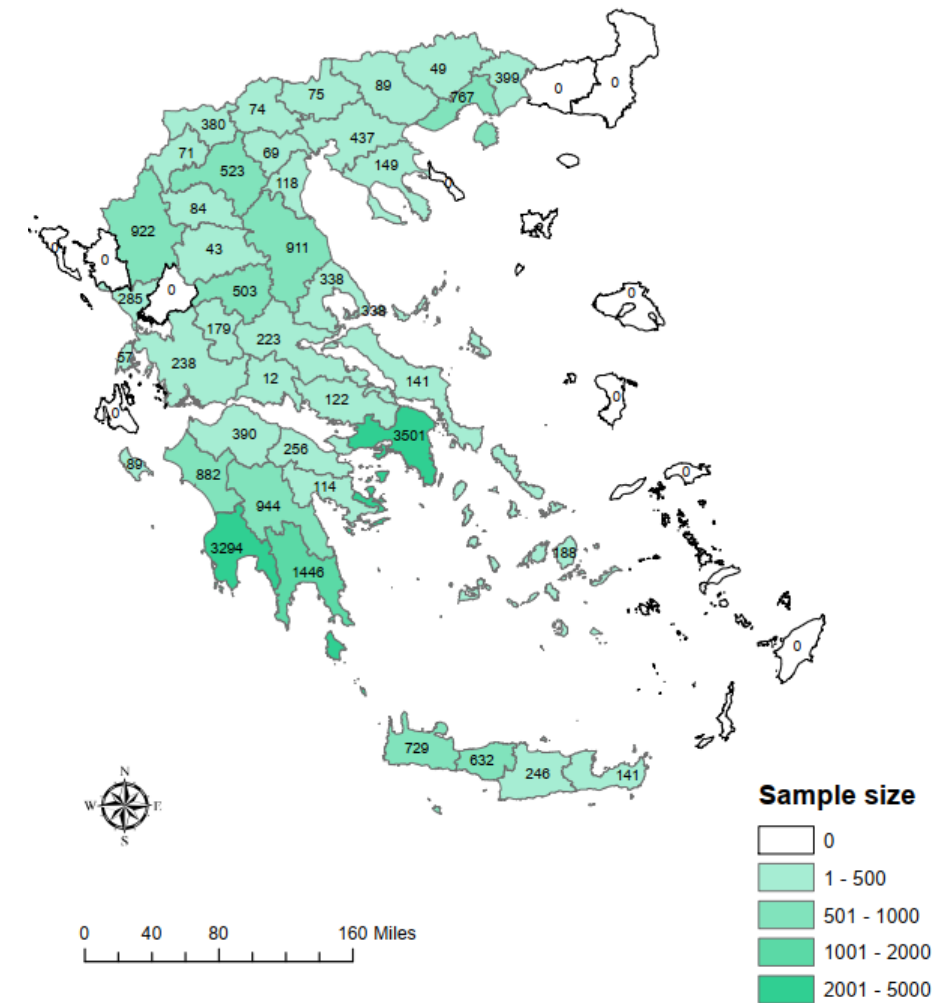
Figure 1. Geographical distribution of leftover samples collected for COVID-19 serosurvey. Some RUs are not covered due to the absence of participating microbiological laboratories.